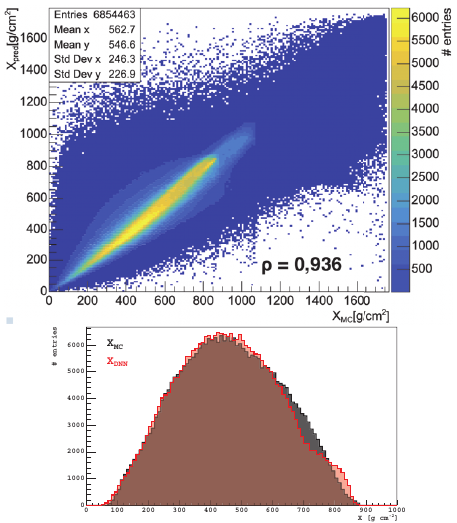
Figure 5. Contributions to the total muon delay for an average of 20 iron-initiated showers with E = 10 17 eV, and θ = 0 ◦ . Top panel: Total distributions for the total (black), geometric (blue) and kinematic (red) delay. Middle panel: geometric (blue) and kinematic (red) delays for muons with E < 1GeV. Bottom panel: geometric (blue) and kinematic (red) delays for muons with 1 < E [GeV] < 2. Please, mind the logarithmic scale in the y -axis used in the top panel.